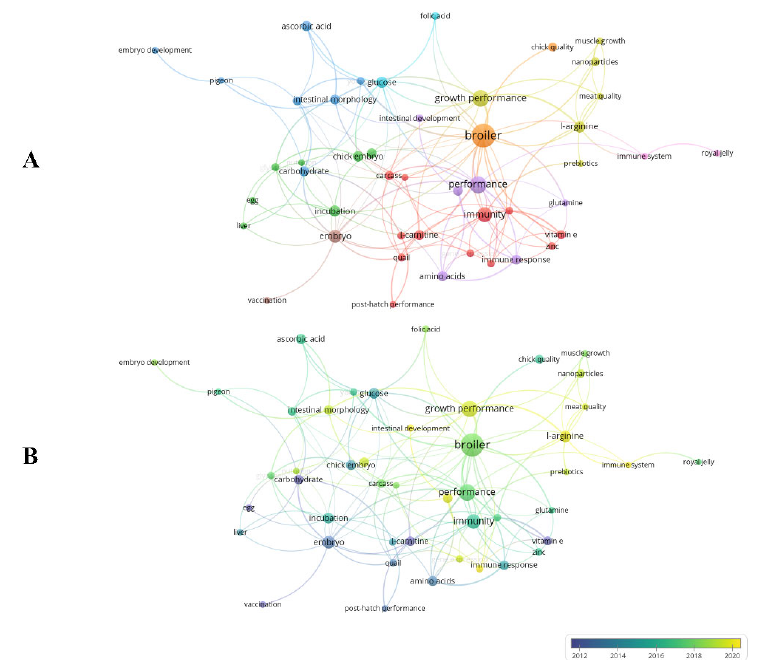
Figure 9. Co-occurrence network of authors’ keywords.